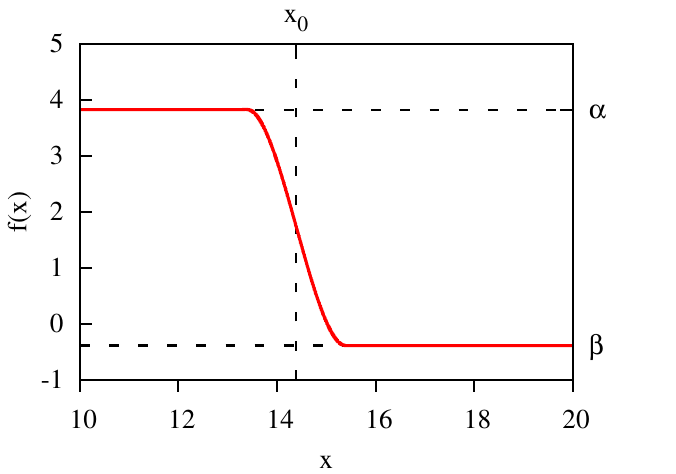
Figure 3. Typical behavior of the function f ( x ) in Eq.